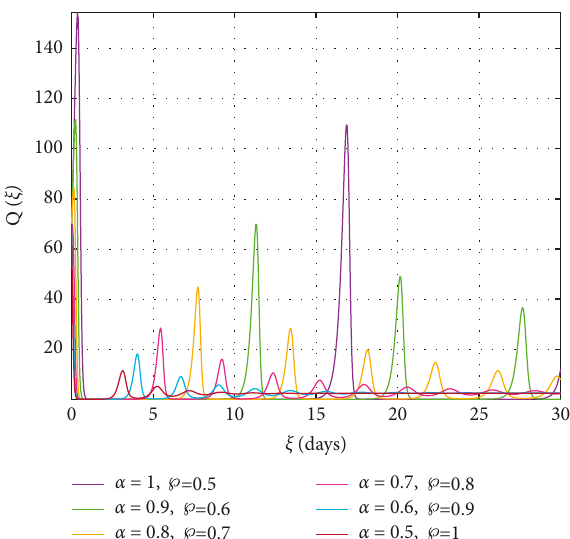
Figure 3: Displays of individuals who quit or not using Q ( ζ ) social media using a Newton polynomial approach for decreasing frac- tional-order α and increasing fractal-dimension ℘